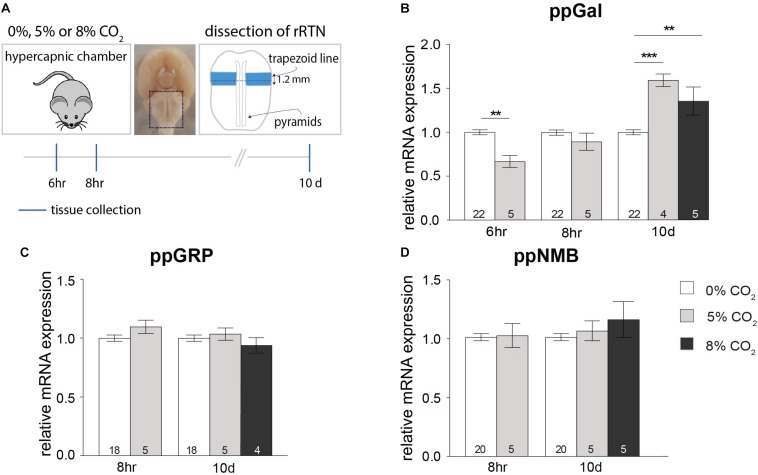
Short-term hypercapnia downregulates and long-term hypercapnia upregulates ppGal but not ppGRP or ppNMB mRNA in rostral RTN (rRTN) measured by qPCR. (A) Strategy for hypercapnia exposure, tissue dissection and timeline for short-term and long-term hypercapnia paradigms. (B–D) ppGal, ppGRP and ppNMB mRNA expression levels following short-term (6 or 8 h) or long-term (10 days) elevated inspired CO2 (5% or 8%). The qPCR results were normalized to the expression levels of two house-keeping genes: HPRT and RPLPO. ∗∗p < 0.01, ∗∗∗p < 0.001 (One-Way ANOVA, Multiple comparisons: Dunnet).